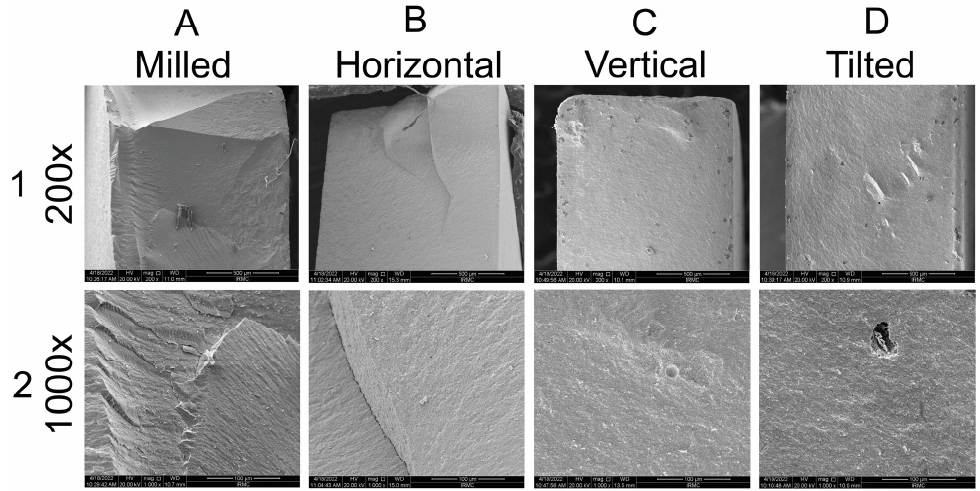
Figure 7. Surface of fractured specimens at ( 1A – 1D ) 200 × and ( 2A – 2D ) 1000 ×